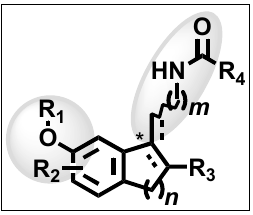
Figure 2. Structure of Benzocycloalkene derivative Source: Uchikawa and Okawa (2006).